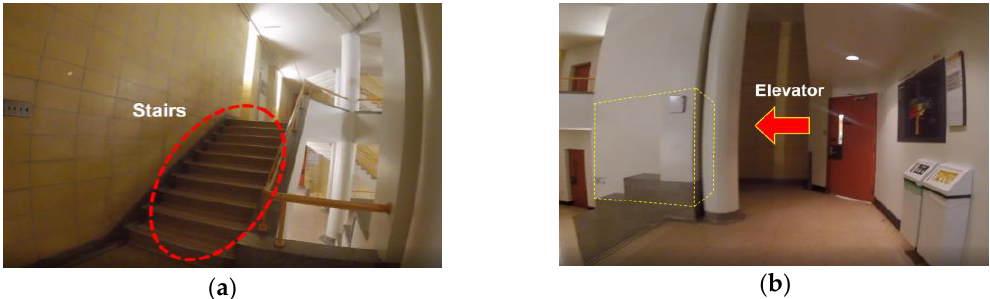
Figure 3. Visual saliency of ( a ) stairs and ( b ) elevator in an intersection at the Geomatics Department, Quebec City.